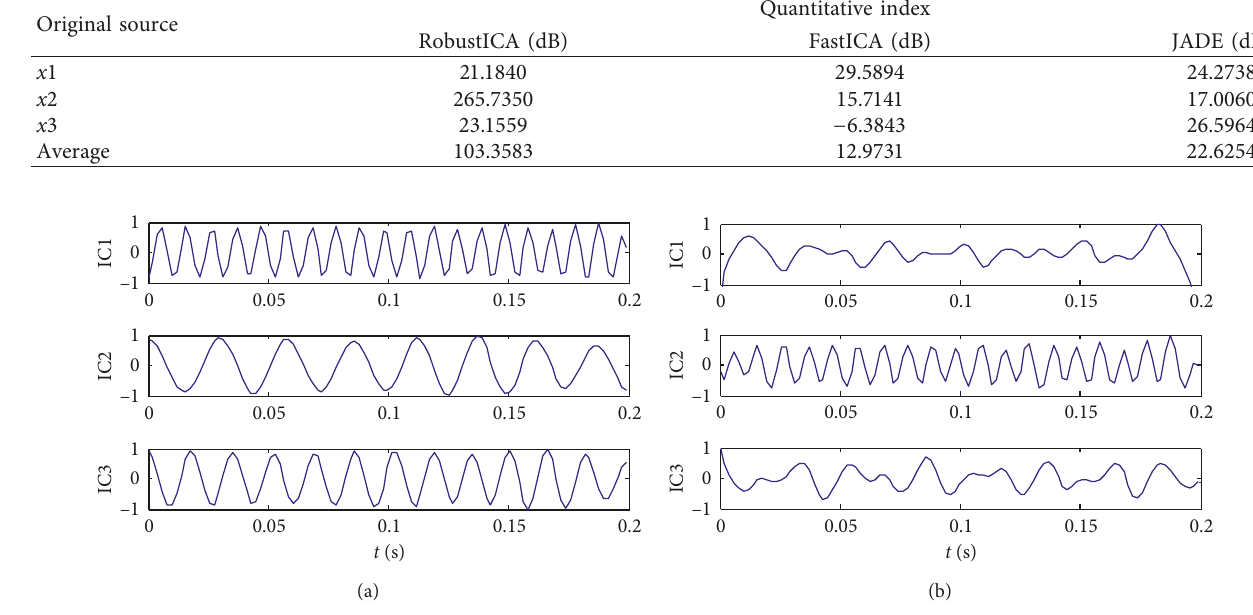
Figure 6: The calculation results by (a) TVF-EMD-RobustICA and (b)